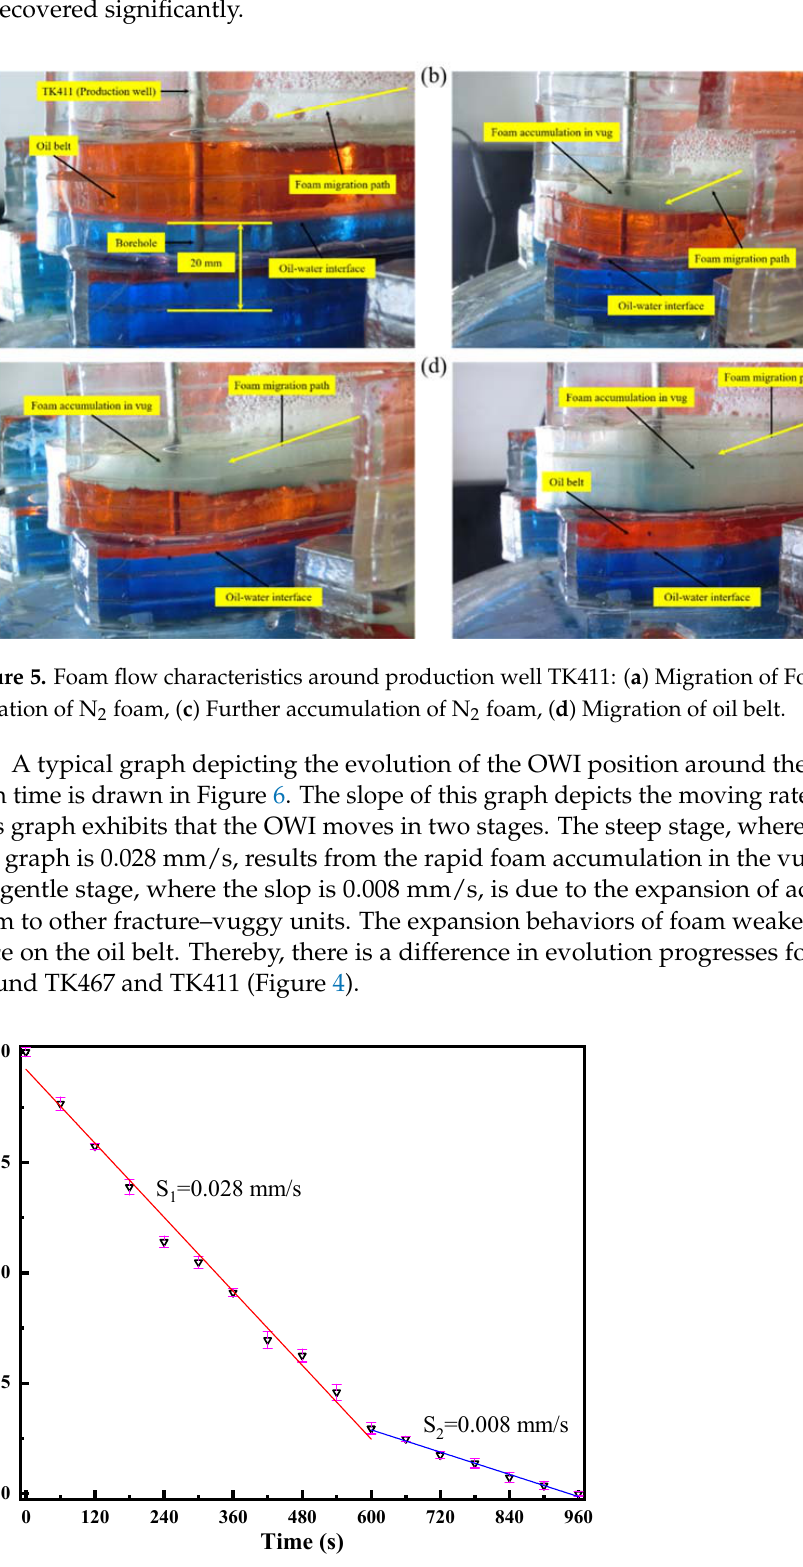
Figure 6. Graph depicting the position of the OWI around the well TK411 with time.